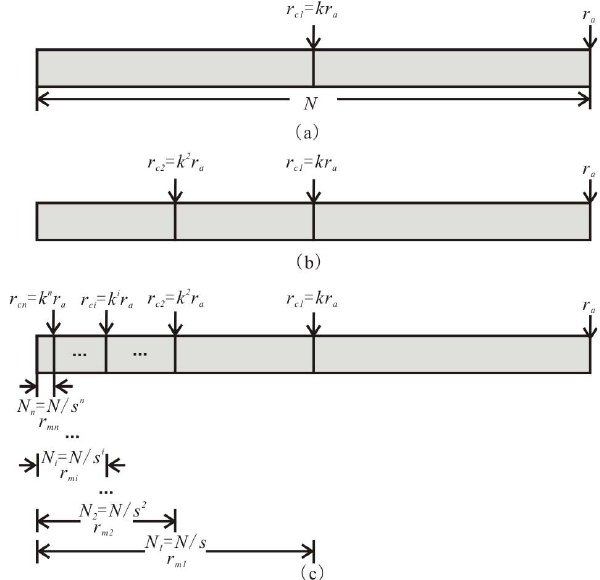
Fig. 7. Fractal model of the gold concentrations in the core samples collected from the 10 selected drill holes, and the tonnage-cutoff and tonnage-grade curves for the selected exploration area in the Reshuitang deposit. (a) Fractal model of the gold concentrations in the core samples; (b) the ln–ln plots of tonnage vs. cutoff and those of tonnage vs. average grade, approving both tonnage-cutoff model and tonnage-grade model display the fractal relationship with the similar fractal dimensions in this case study. G m1 is obtained by a thickness weighted average gold concentrations of all the sam- ples analyzed in the selected drill holes. G m2 is the average grade derived from GBM. The circles, triangles and rectangles represent the plots of O( ≥ G c ) vs. G c , O( ≥ G c ) vs. G m1 , and O( ≥ G c ) vs. G m2 , respectively; and the black and solid symbols are the plots contained in the fitting, and the grey and hollow plots are not in- volved in the